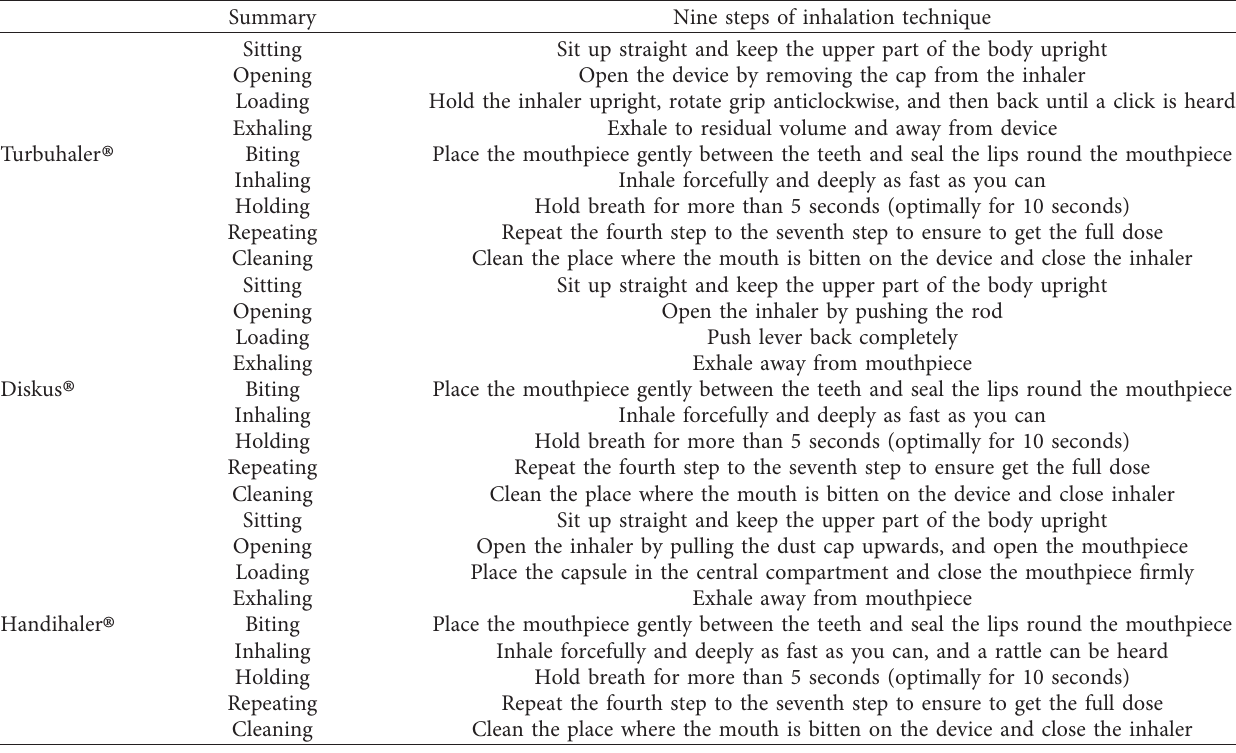
Table 1: Nine-step inhalation